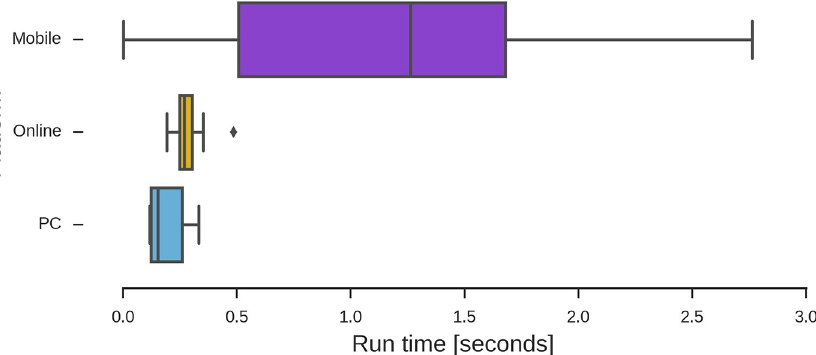
Fig 1. Distribution of calculation times on different computing platforms. The sample script used for testing (described in S3 File) is a modified version of one solution submitted by students to the contest. A total number of 25 different smartphones were used for the test and compared with desktop computers and Python on line